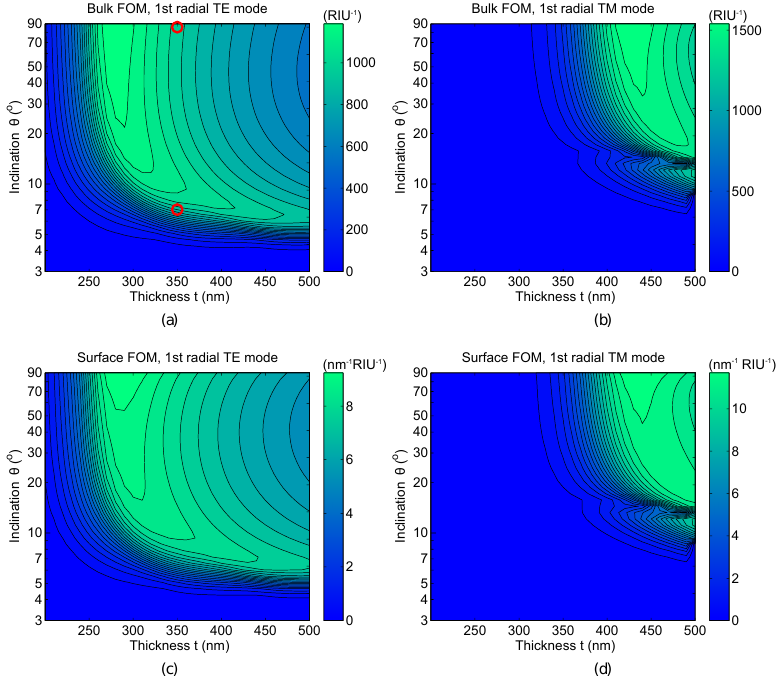
Figure 4. Figure or merit (FOM) analysis performed on the first radial TE ( a , c ) and TM ( b , d ) modes, as a function of the wedge inclination θ and thickness t . The plots report the bulk ( a , b ) and superficial ( c , d ) figure of merit FOM